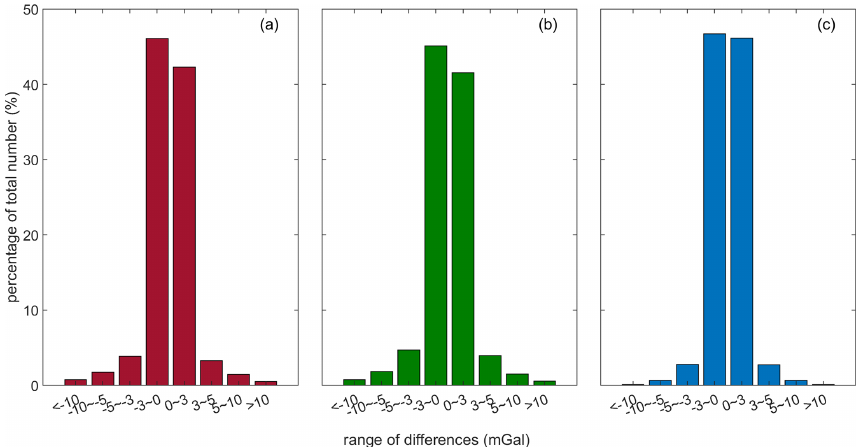
Figure 8. Histograms of difference between altimeter-derived oceanic gravity anomaly models: (a) is for DTU17 and SIO V30.1, (b) is for SDUST2021GRA and SIO V30.1, and (c) is for SDUST2021GRA and DTU17.